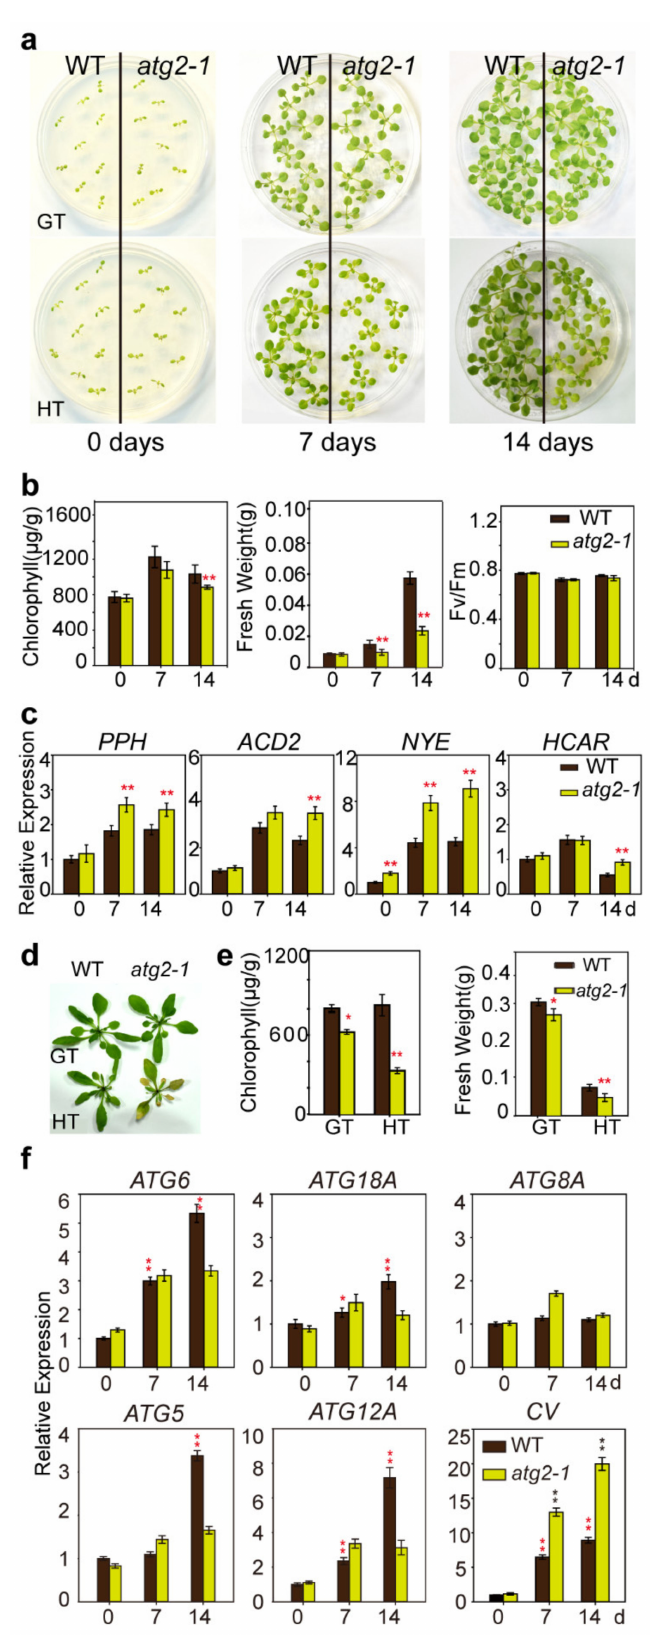
Figure 7. Characterization of ATG2 -deficient plants under high temperature conditions. ( a ) Seven-day-old WTand atg2-1 mutantplantsgrownunderhightemperature(HT,30 ◦ C)andgrowthtemperature(GT,22 ◦